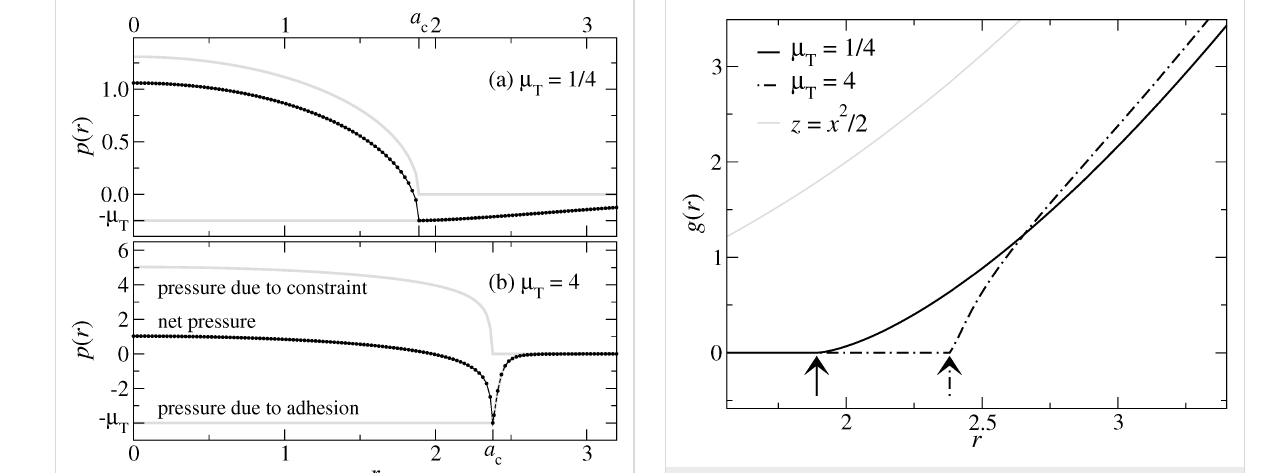
Figure 6: Gap between a rigid, adhesive, parabolic tip and a linearly- elastic half space for two different Tabor coefficients μ T = 1/4 (solid black line) and μ T = 4 (broken black line). The gap z = x 2 /2 of an unde- formed half-space is shown in grey for comparison. Arrows indicate contact radii. Units are chosen according to Equation 23–Equation 26.